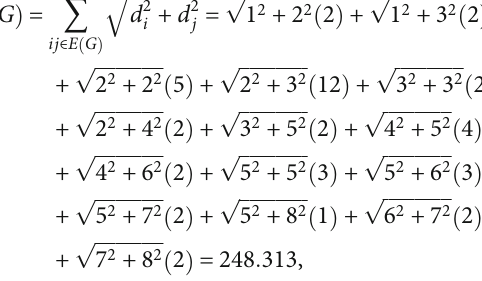
p 1 2 + 3 2 p 3 2 + 3 2 p 4 2 + 5 2 p 5 2 + 6 2 p 6 2 + 7 2